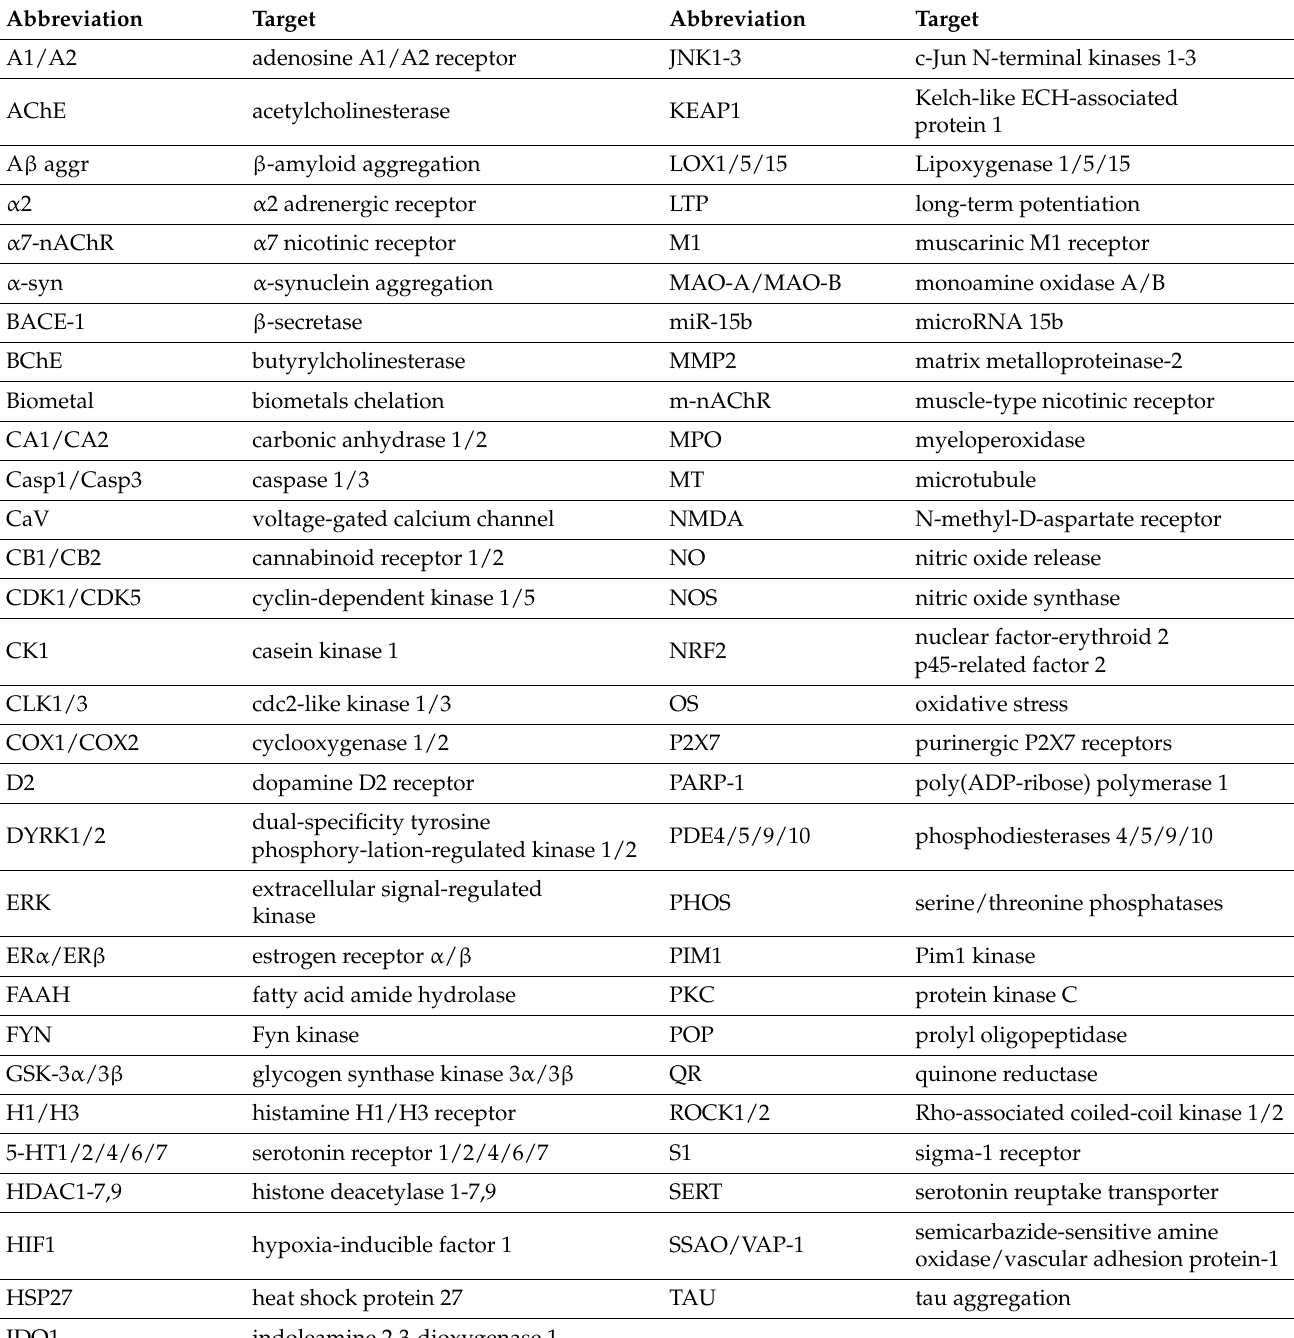
Table 1. List of biological targets pursued in multitarget anti-AD agents and their